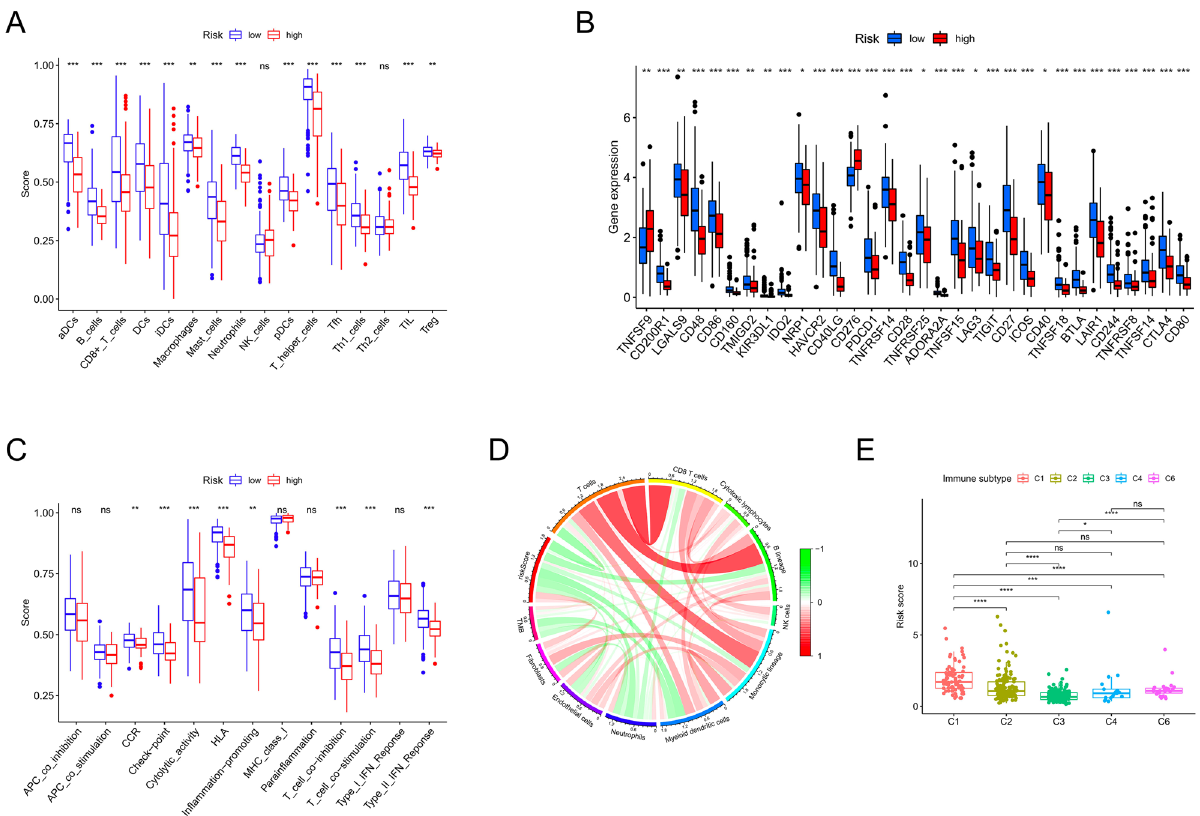
Figure 7. Correlation analysis between prognostic model and immune using R software. ( A ) Differences in 16 immune infiltration cells between high- and low-risk groups. ( B ) Differences in gene expression level of immune checkpoint-related genes between high- and low-risk patients. ( C ) Differences in 13 immune-related function between high- and low-risk groups. ( D ) Relationship among estimated infiltration abundances of immune cells, risk score and TMB. ( E ) Differences in risk scores of different immune subtypes. * p -value < 0.05, ** p -value < 0.01, *** p -value <